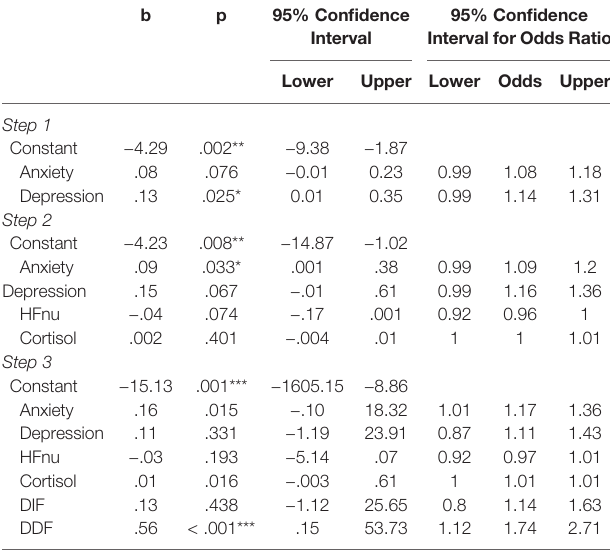
TABLE 7 | Summary of hierarchical logistical regression analysis predicting the presence of Crohn ’ s disease (CD) (95% BCa bootstrap con fi dence intervals based on 5,000